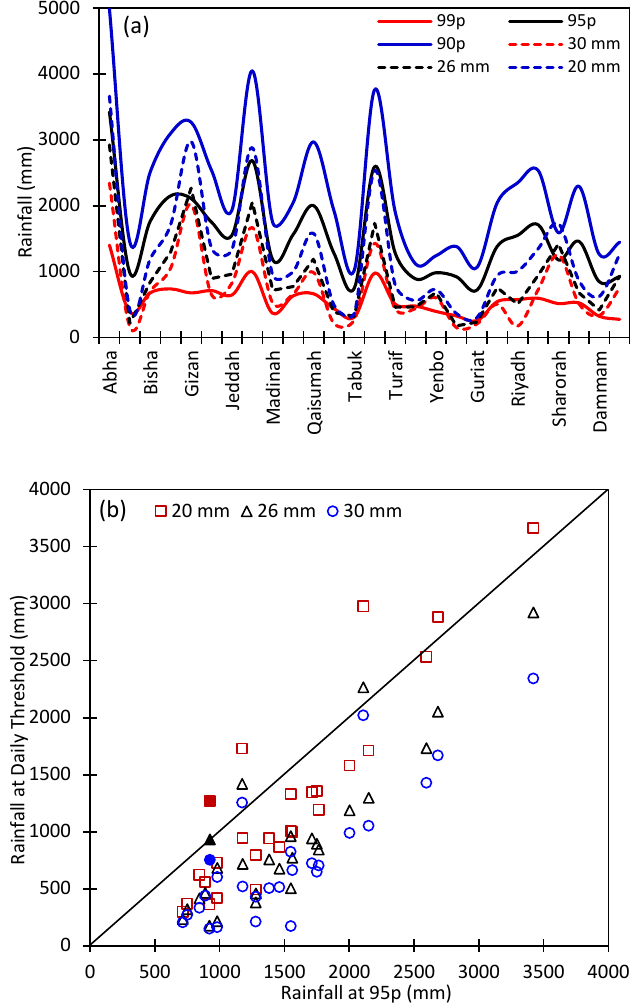
Figure 14. ( a ) Amount of rainfall (mm) at the 90th, 95th, and 99th percentiles along with at the ≥ 20, ≥ 26, and ≥ 30 mm thresholds in Saudi Arabia for the period 1978–2019. ( b ) Scatter plot of the percentile-based and threshold-based rainfall. The open-square, triangle, and circle represent station values, while the closed square, triangle, and circle represent the country average at ≥ 20, ≥ 26, and ≥ 30 mm,